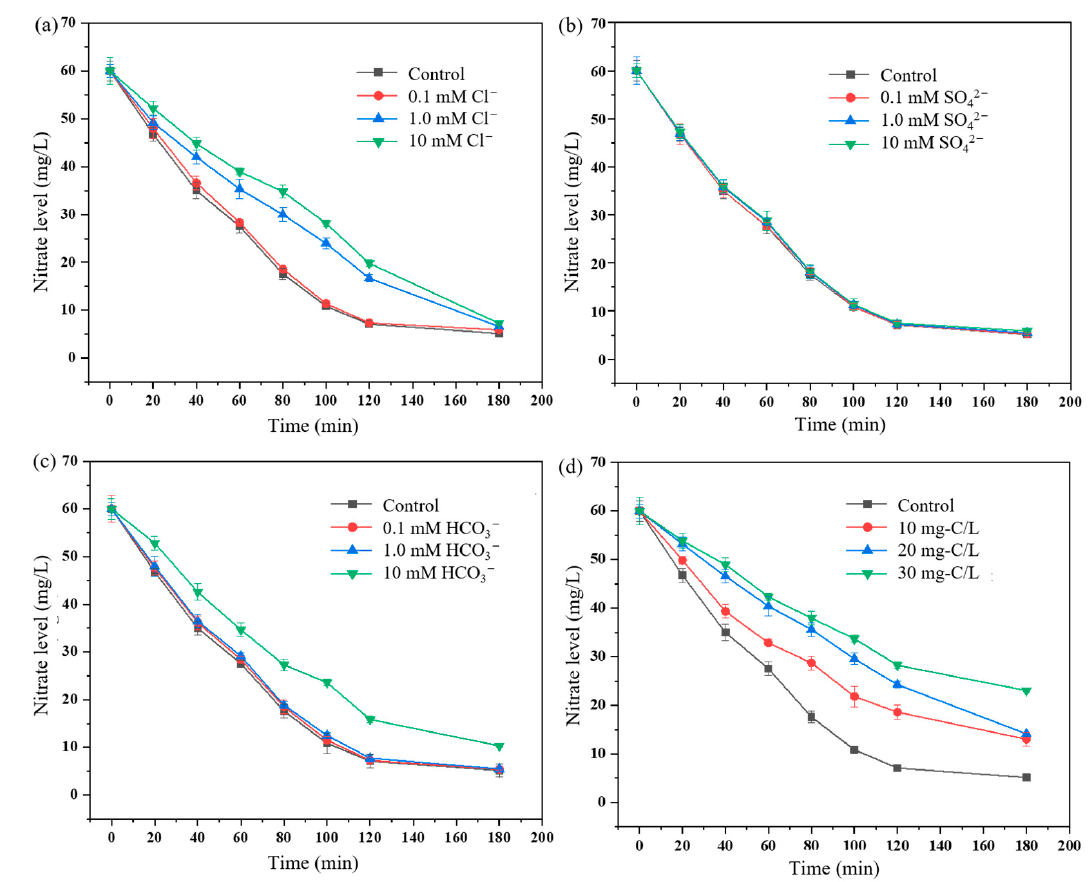
Figure 6. The effect of concentrations of ( a ) Cl ‒ (0, 0.1, 1.0, and 10 mM), ( b ) SO 42 ‒ (0, 0.1, 1.0, and 10 mM), and ( c ) HCO 3 ‒ (0, 0.1, 1.0, and 10 mM), as well as the effect of ( d ) humic acids (0, 10, 20, and 30 mg-C/L) on NO 3 ‒ reduction in the UV/C 2 O 4 ‒ /Fe 3+ process. Experimental conditions: [NO 3 ‒ ] 0 = 60 mg/L, [C 2 O 42 ‒ ] 0 = 3 mM, [Fe 3+ ] 0 = 0.05 mM, I 0 = 10.2 mW/cm 2 (wavelength = 365 nm), [DO] 0 = 0.5 ± 0.1 mg/L, pH ini. = 7.0 ± 0.2, and T = 25 ± 0.5 °C. Error bars represent the standard deviation from three experiments. Error bars smaller than symbols are not visible.